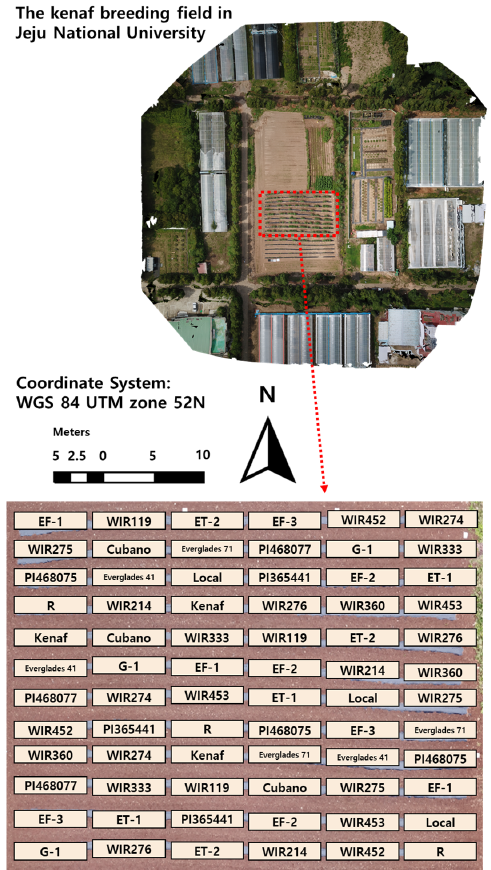
Figure 1. The field utilized in this study. The letters in each box indicate the names of the cultivars.